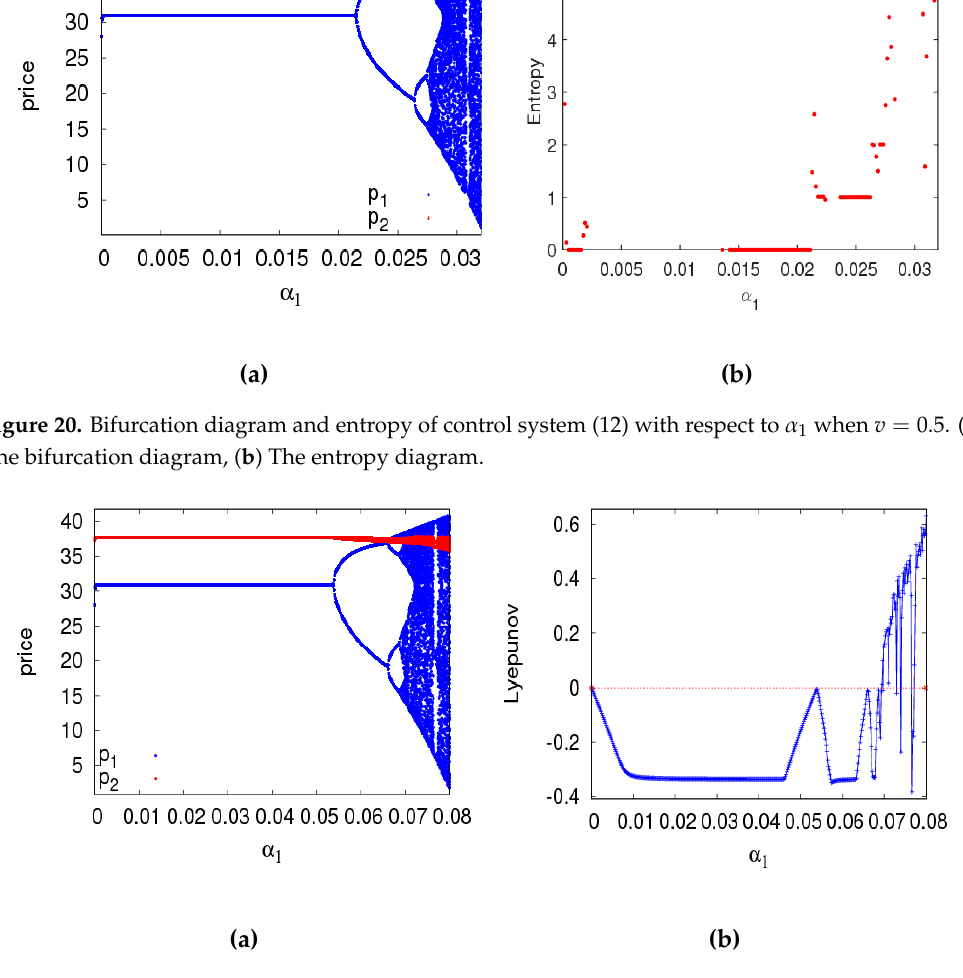
Figure 21. Bifurcation diagram and entropy of control system (12) with respect to α 1 when v = 0.8. ( a ) The bifurcation diagram, ( b ) The LLE diagram.